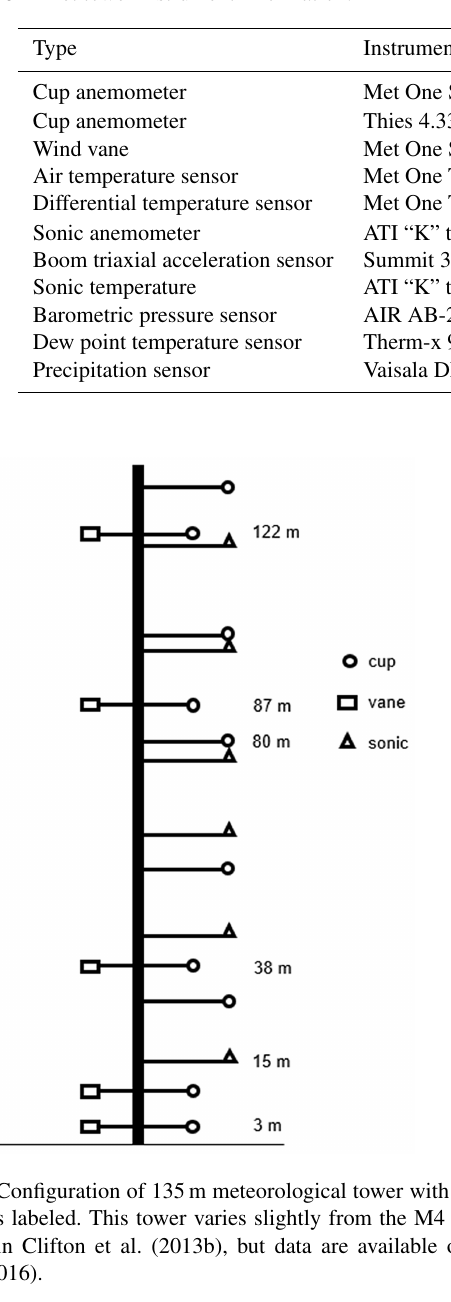
Table 1. 135m met tower instrument information.